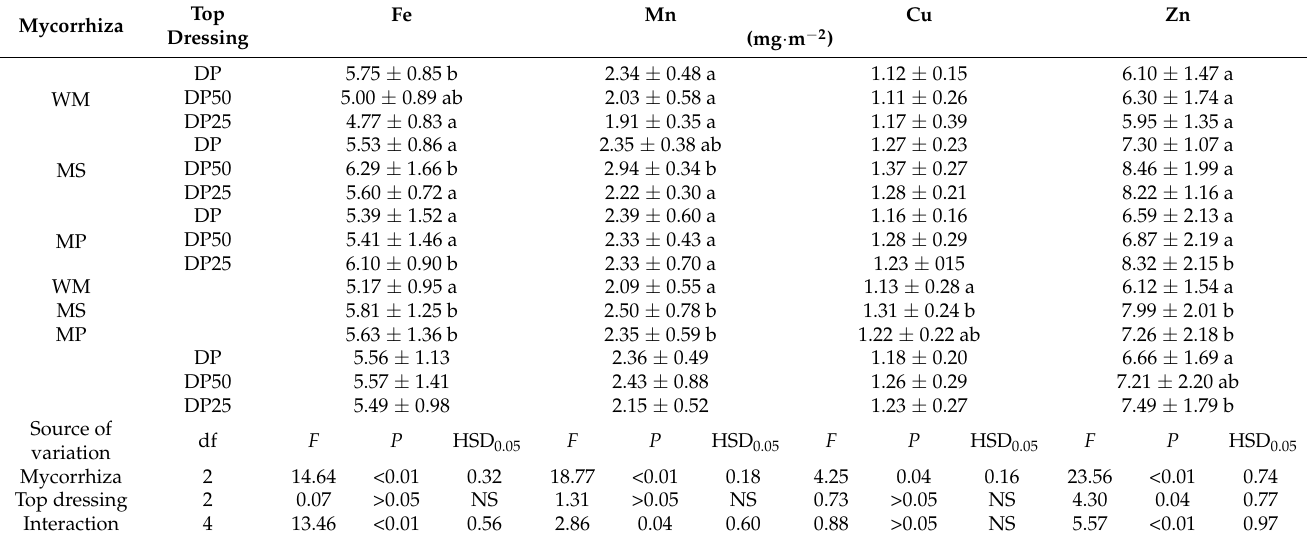
Table 6. The amount of micronutrients accumulated in the total yield of sweet pepper fruits; on average across three years (2014–2016).